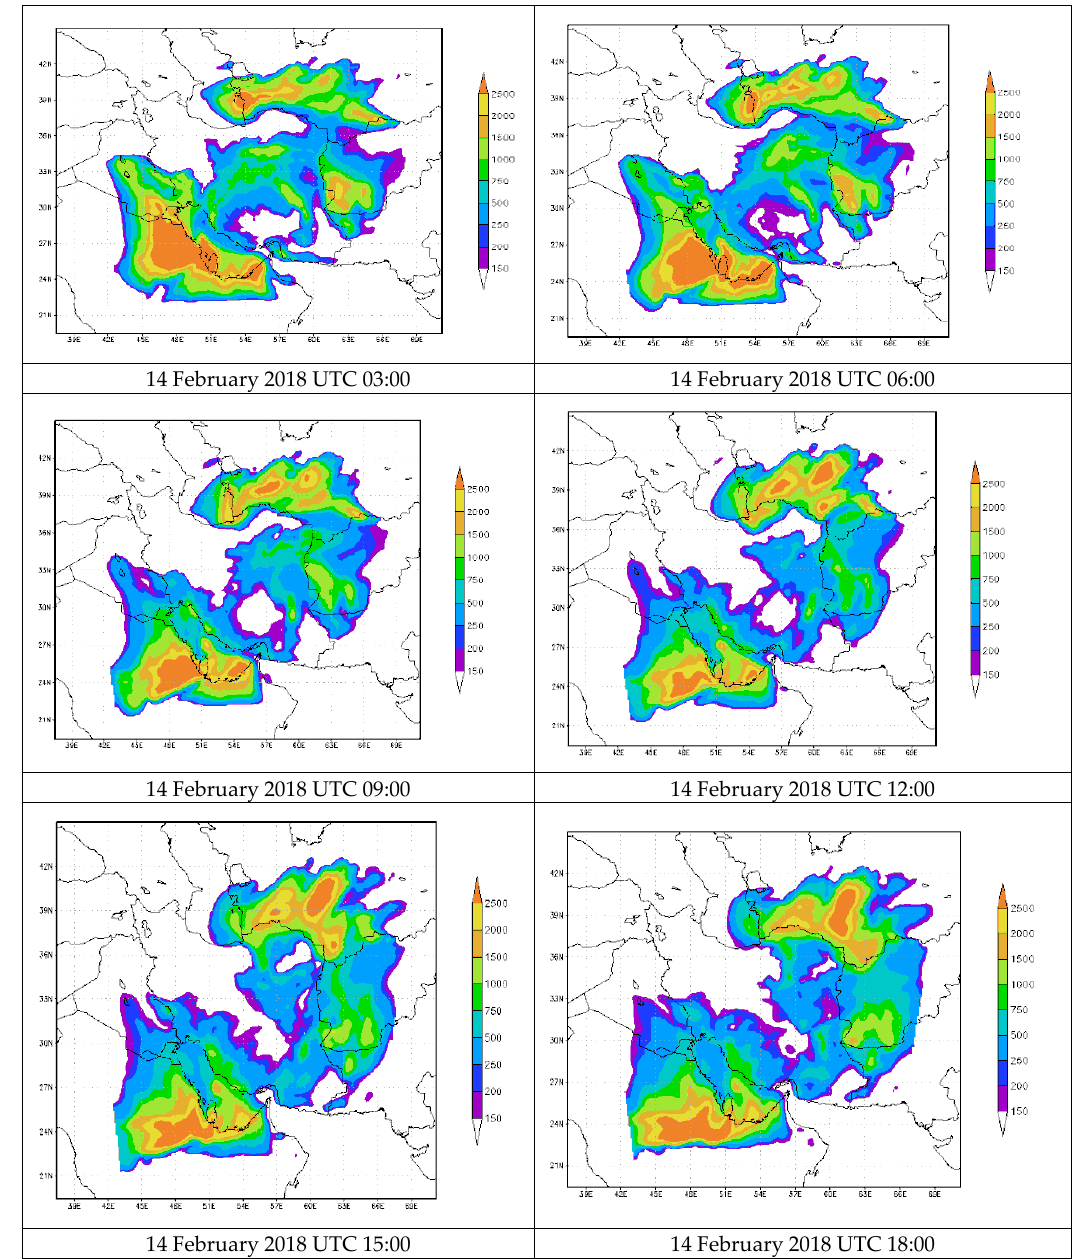
Figure 17. Spatial pattern of dust surface concentration ( µ g/m 3 ) from WRF-Chem with GOCART scheme in 14 February 2018.